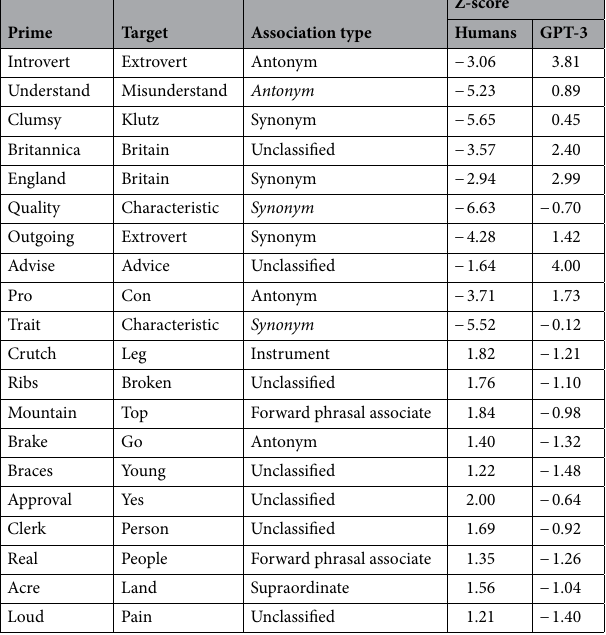
Table 1. Largest differences in semantic activation between humans and GPT-3. Association types printed in regular font come from the Semantic Priming Project database; those printed in italics were missing and were added by